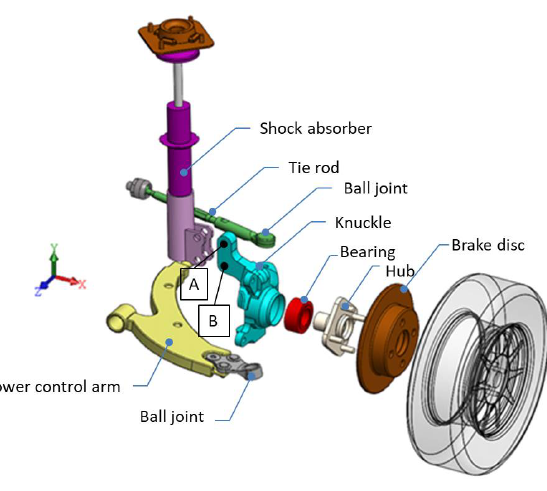
Figure 10. Geometric quarter model of vehicle suspension system.